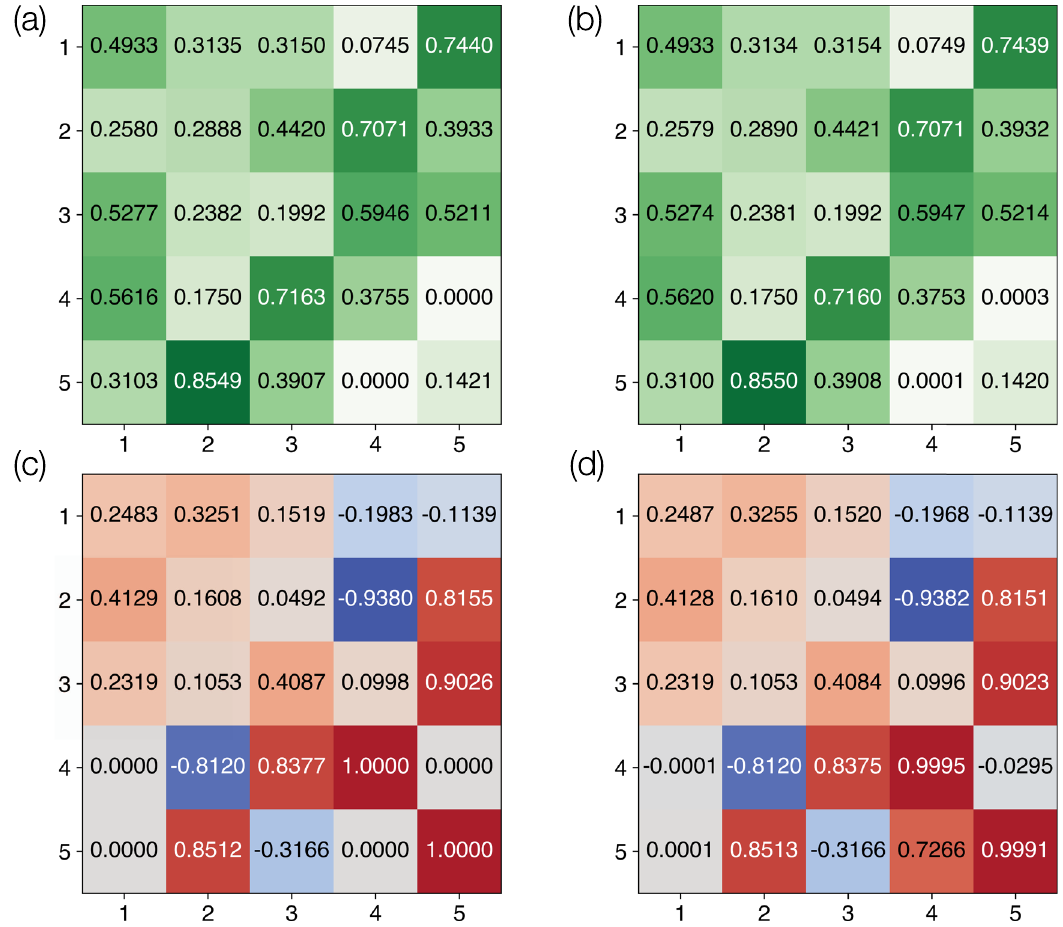
Fig. 6 Implementing non-unitary transformations with unitary embedding. The target non-unitary matrix, located in the upper-left 3 × 3 section of the matrix, is fi rst extended to a unitary 5 × 5 target matrix. The element-wise a target amplitude, b achieved amplitude, c target phase, and d achieved phase as a fraction of π are shown. A near ideal implementation was achieved using N r = 4 and N f = 4 with a fi delity exceeding 1 − 10 − 5 . Modulation parameters are provided in Supplementary Note